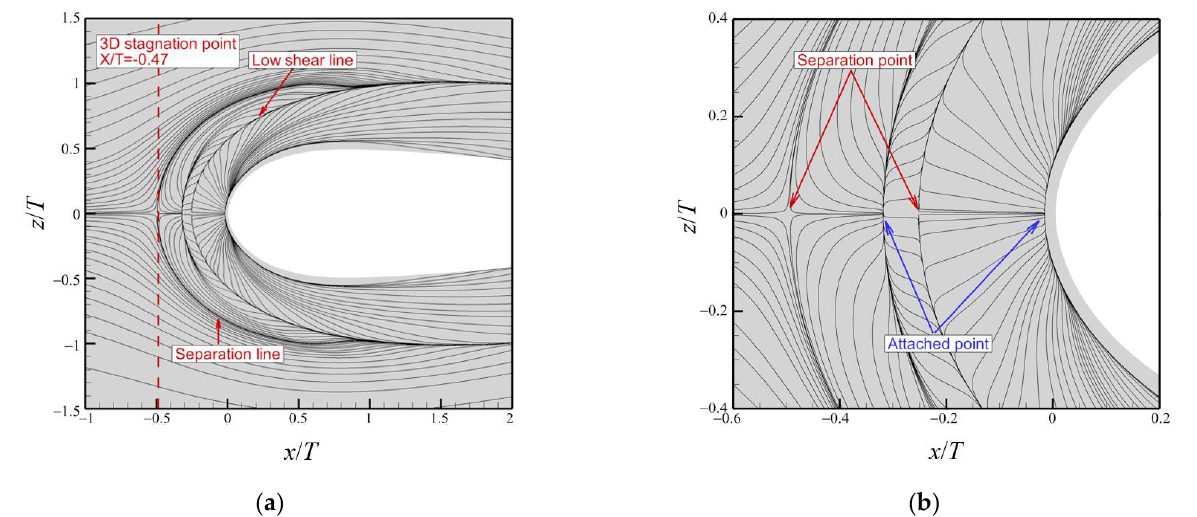
Figure 4. Streamlines at junction nose calculated using k – ω SST: ( a ) streamlines; ( b ) four-vortex system.